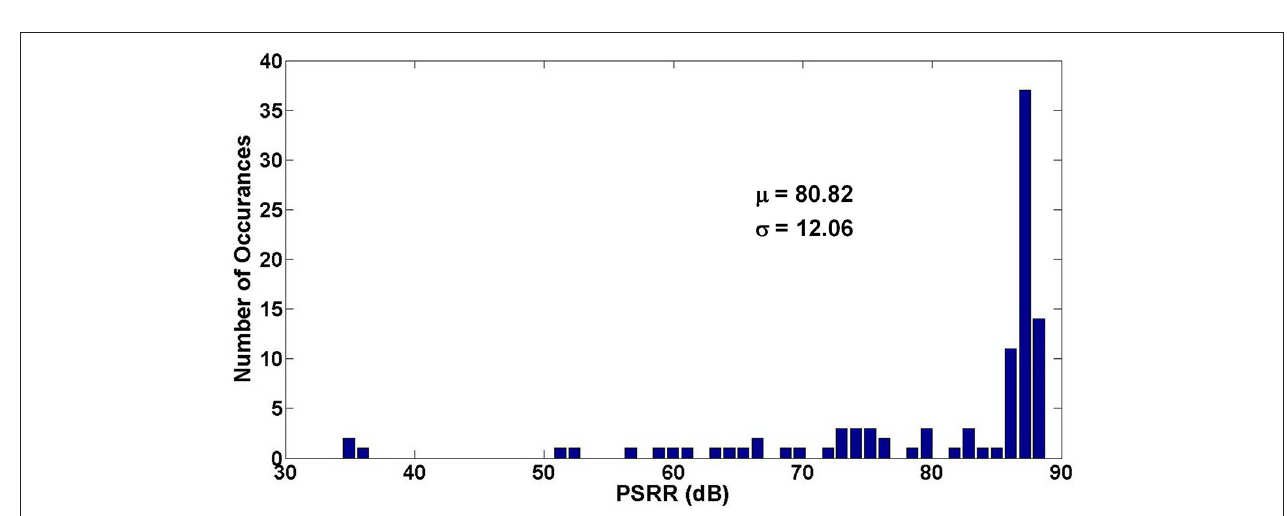
FIGURE 16 | Monte Carlo analysis of PSRR of the neural